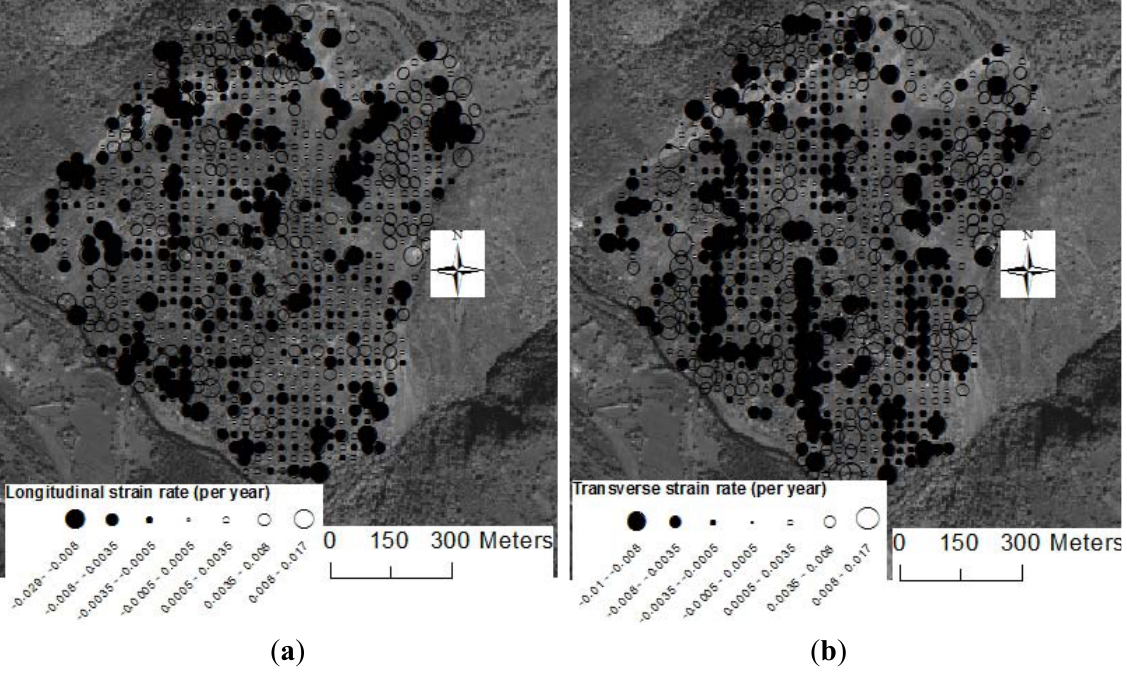
( a ), transverse (cid:2013)(cid:4662) ( b ), and shear (cid:2013)(cid:4662) ( c ) strain rates and the (cid:3013) (cid:3021) (cid:3013)(cid:3021)